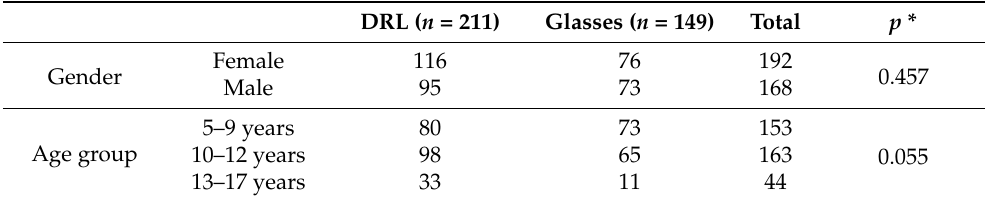
Table 1. Demographics of the qualitative variables at the beginning of treatment.